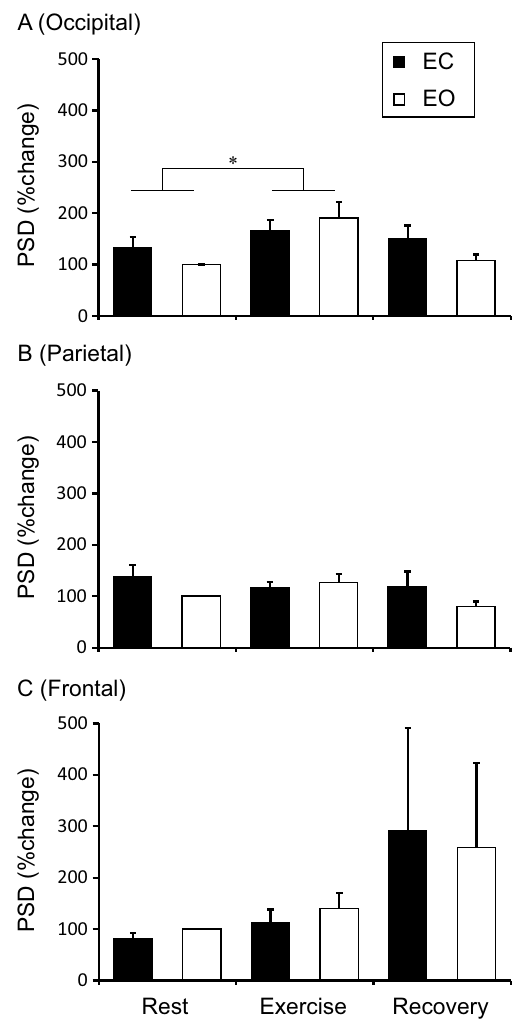
Figure 3. Theta power spectrum densities in occipital (A) , parietal (B) , and frontal (C) site at the rest, exercise, and recovery periods. The values indicate percentage change from Rest + EO and are shown as the mean ± standard error (N = 15). * p < 0.05. PSD power spectrum